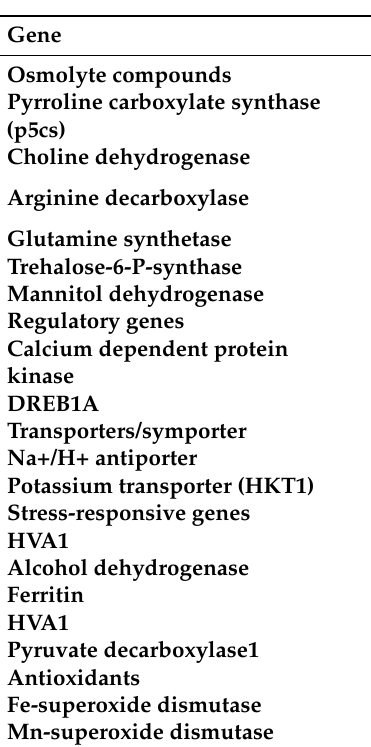
Table 4. Transgenic crop plants developed for AbS tolerance